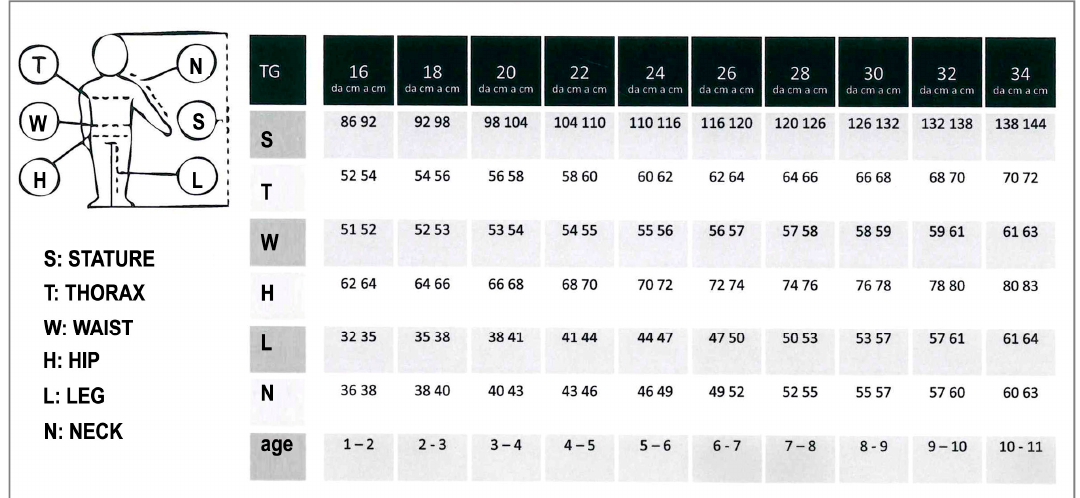
Figure 1. Synoptic schedule related to the anthropometric relationships of children as their height